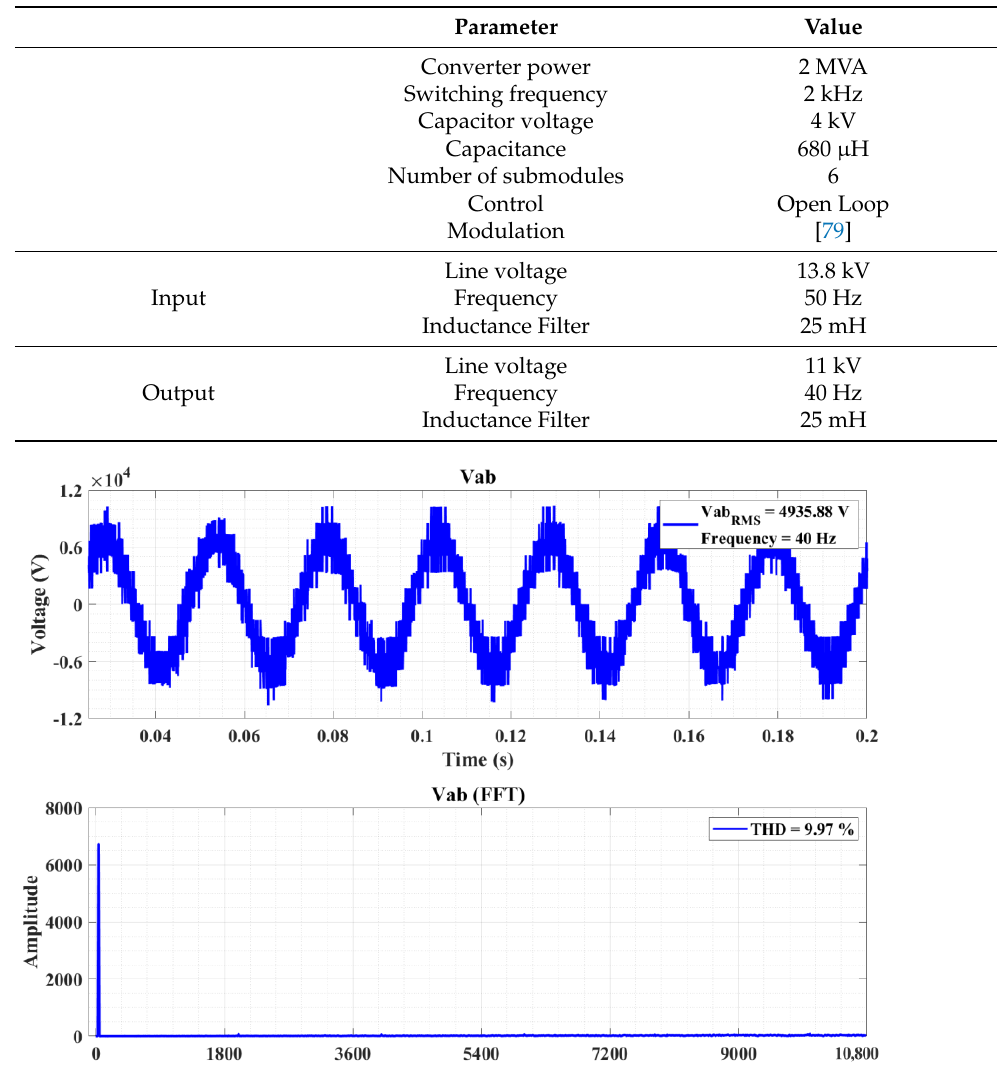
Table 5. Parameters used in simulation.